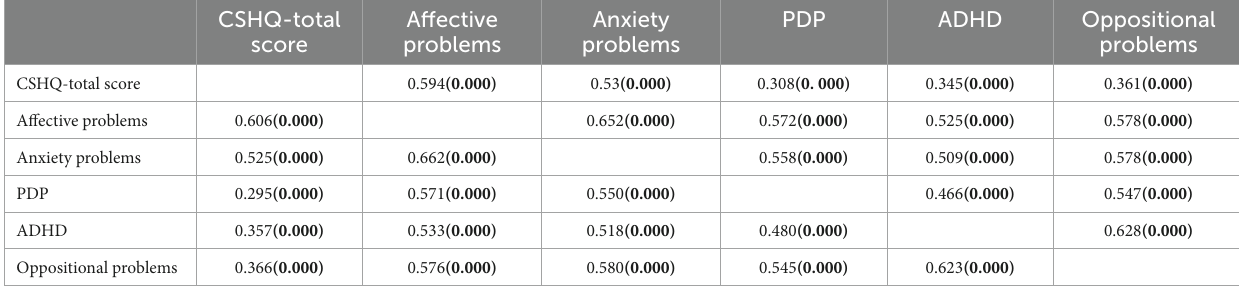
TABLE 4 Pearson correlations among the CSHQ total score and the CBCL DOS